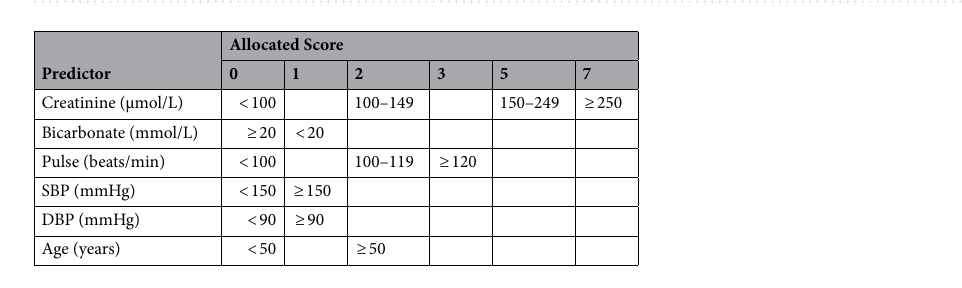
Table 2. Six-variable AKI Risk Score (AKI-RiSc) breakdown. SBP systolic blood pressure, DBP diastolic blood